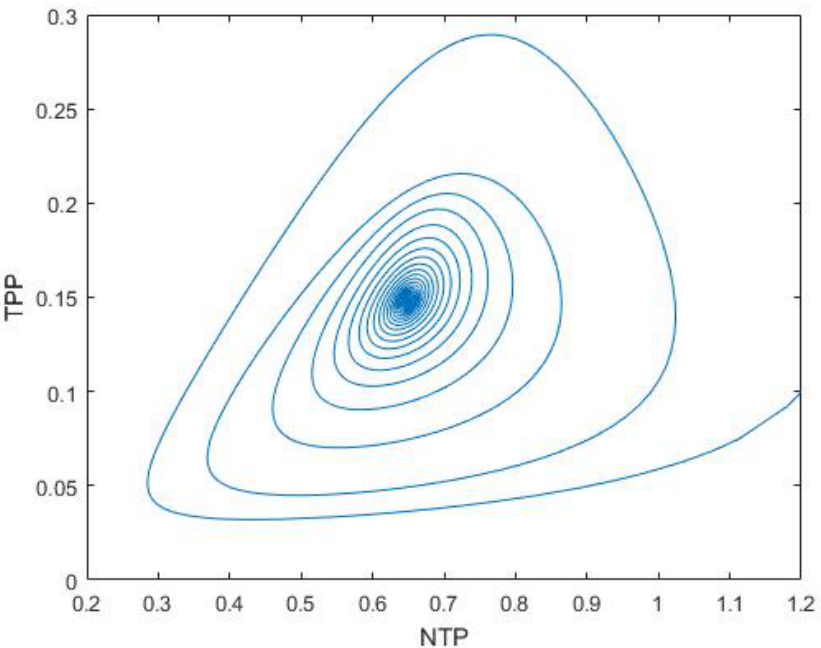
Figure 9. The asymptotical stability of the equilibrium between the NTP and TPP populations for τ = 30 > τ 0